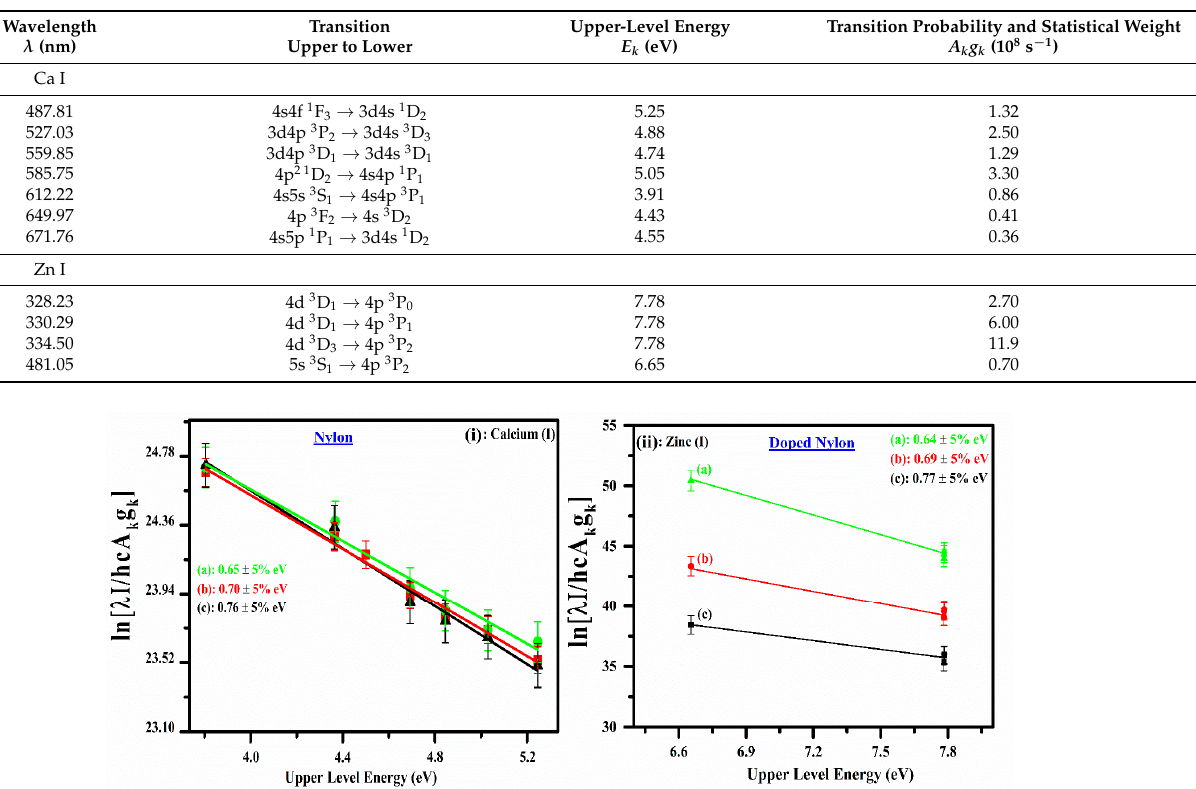
Table 1. Spectroscopic atomic parameters of the emission lines for the calculation of excitation temperature [37].